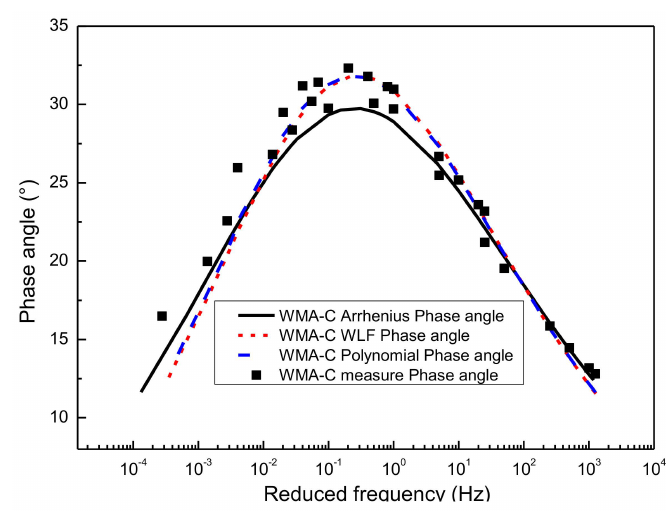
Figure 14. Predict phase angle master curve of WMA-C from generalized